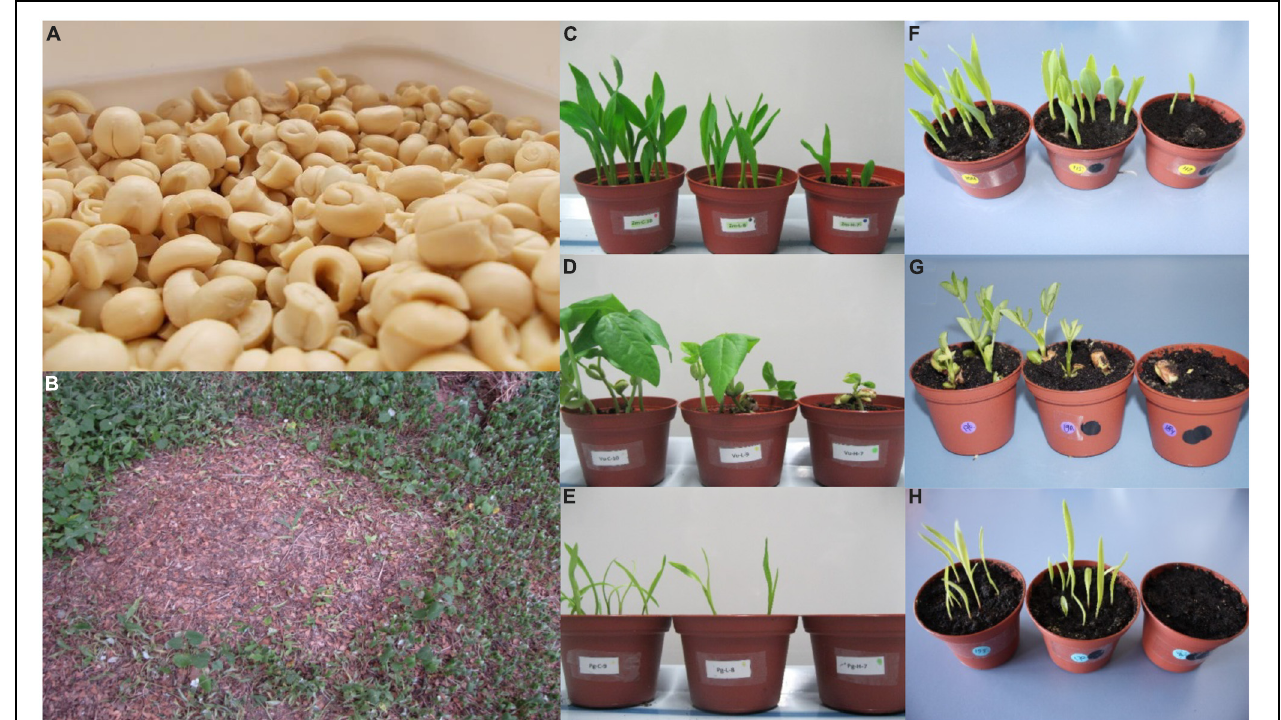
FIGURE 1 | (A) : Hanza, (B) Effect of watering standing vegetation with hanza waste water in Zinder, Niger. (C–E) : effects of hanza waste water on germination of Zea mays (C) , Vigna unguiculata (D) , and Pennisetum glaucum (E) . Treatments (from left to right in each picture): Tap water, Low (waste water days 4–6), and High (days 1–3); (F–H) :